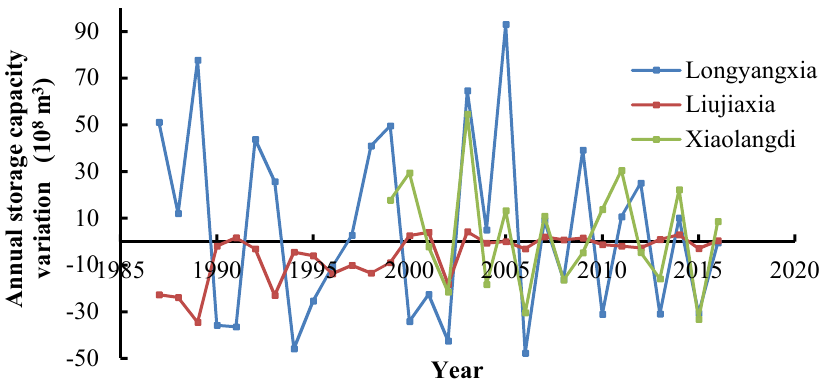
Figure 16. Variations of annual storage capacity of Longyangxia, Liujiaxia and Xiaolangdi reservoirs along the Yellow River.